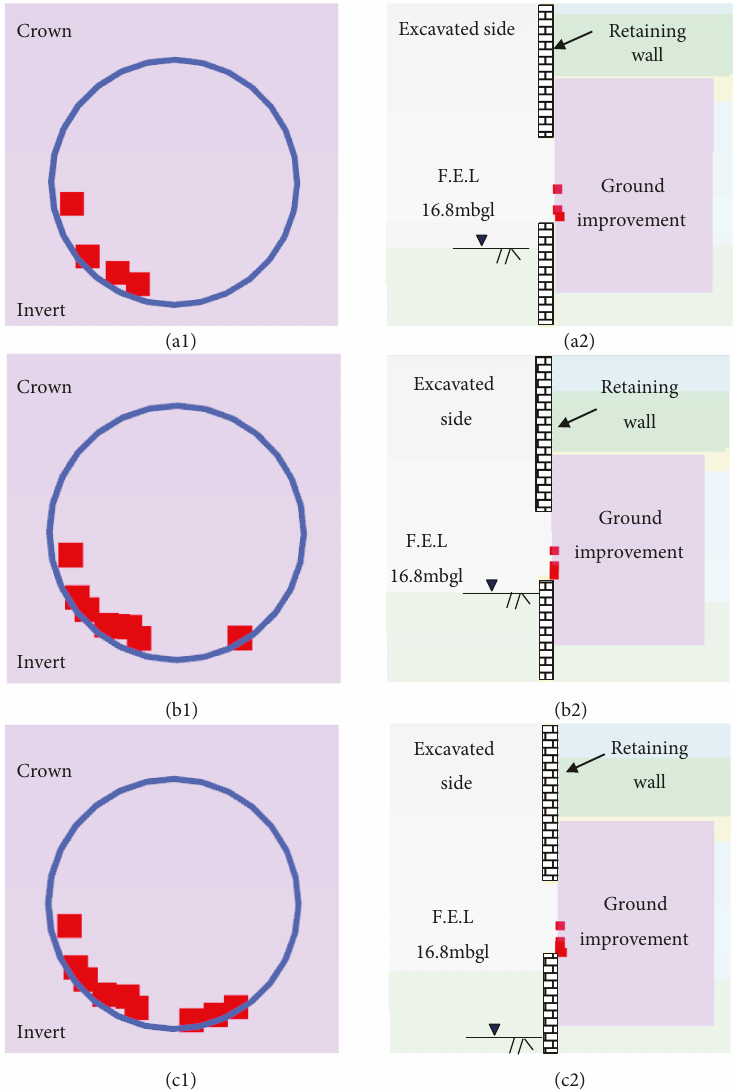
Figure 14: Impacts from various soil permeability on failure caused by launching of a shield. Note: “ 1 ” means transverse direction and “ 2 ” means longitudinal direction. (a) 10 − 6 cm/sec, (b) 10 − 5 cm/sec, and (c) 10 − 4